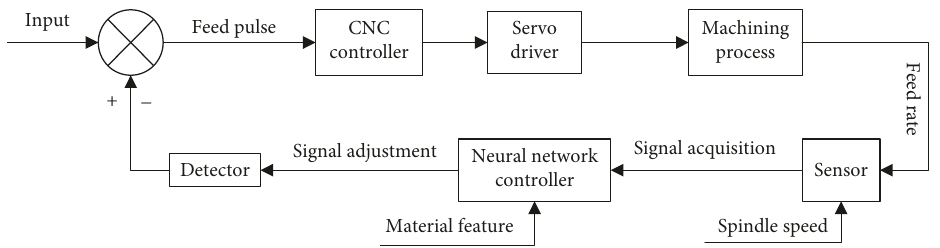
Figure 4: Nanomaterial neural network real-time monitoring